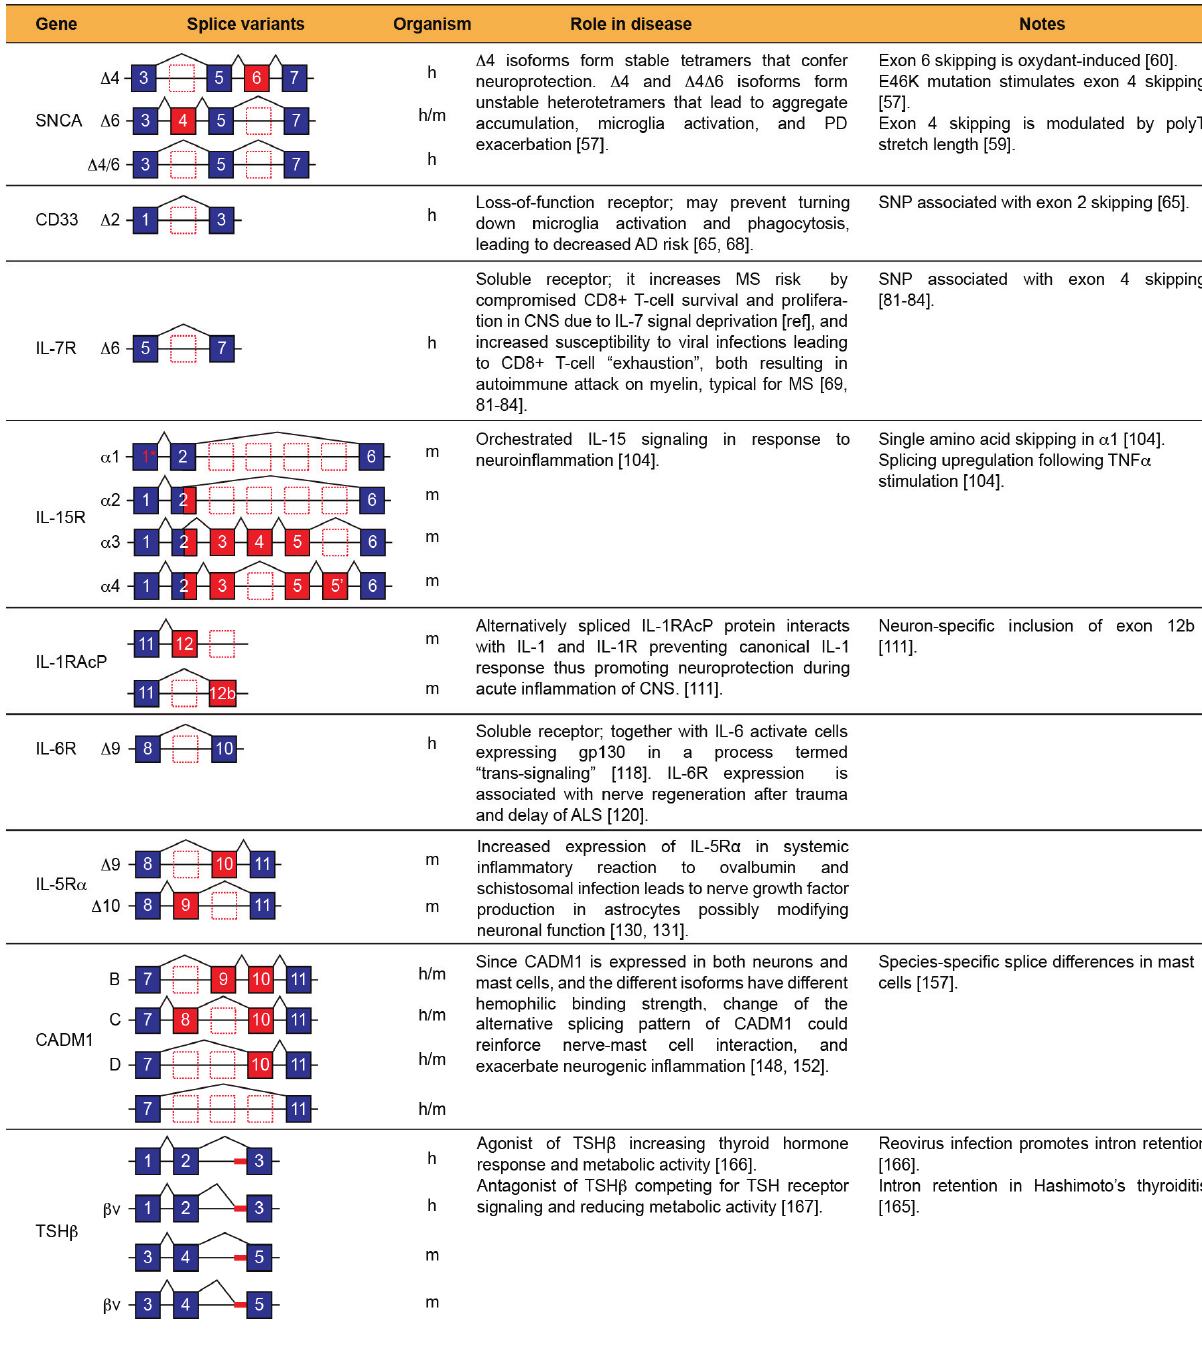
Figure 2. Alternatively spliced isoforms mediating communication between the nervous system and the immune system during inflammation, and their capacity to alter disease outcome. The organism in which the splice forms have been characterized is indicated (h: human; m: